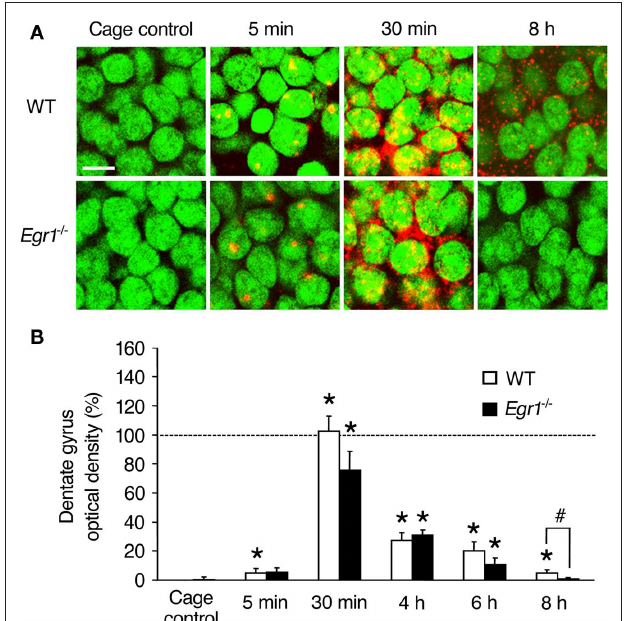
FIgure 2 | Arc mrNA expression after eCS in the dentate gyrus (Dg) of WT and Egr1 − / − mice. (A) Representative images of Arc mRNA detection in granule cells of the dentate gyrus in cage control mice and at different times after ECS. Cell nuclei appear in green (Sytox) and Arc mRNA signal in red (or yellow in the nucleus). Arc mRNA is intra-nuclear 5 min after ECS and mainly cytoplasmic 30 min after ECS. Scale bar, 10 μm. (B) Optical density of Arc mRNA signal in dentate gyrus. ECS-induced Arc mRNA expression is maintained for at least 8 h in WT mice, but decays more rapidly in Egr1 − / − mice and is not significantly above the cage control baseline level after 6 h. *Different from cage controls of the same genotype, at least p < 0.05. #Difference between genotypes, p = 0.06. Dashed line indicates 100% (normalized to WT 30 min).